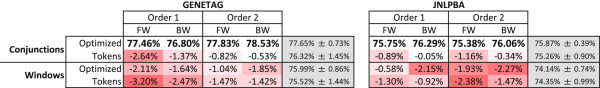
Comparison of windows and conjunctions results on development sets. Comparison of F-measure results achieved by token-based and optimized windows and conjunctions in the development sets of both corpora, considering exact matching evaluation, different model orders and text parsing directions. Results for the JNLPBA corpus indicate the overall performance, i.e. across entity types. FW: Forward, and BW:Backward.